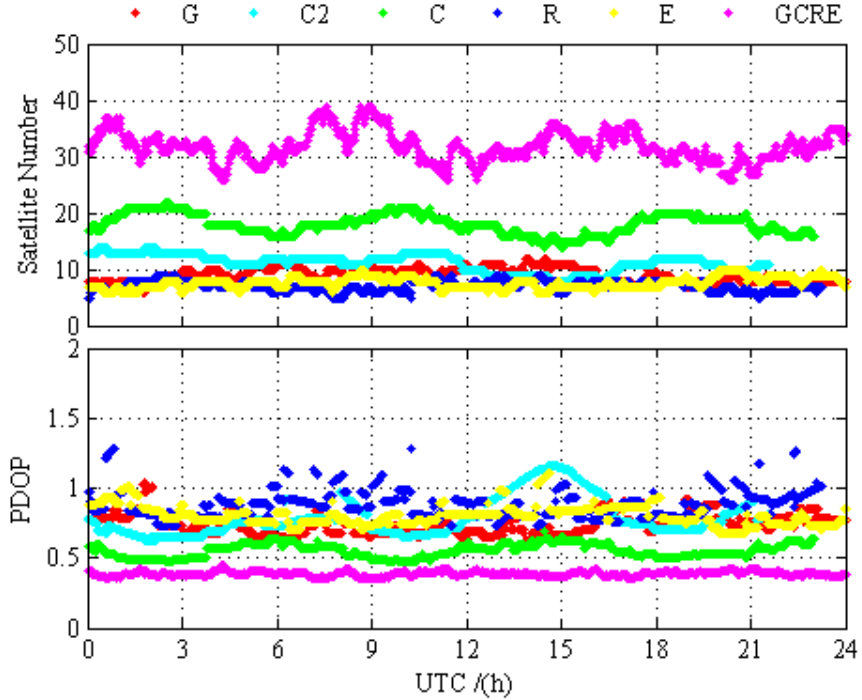
Figure 8. Number of satellite and PDOP at KUN1 for GPS-only, BDS-2-only, BDS-2/BDS-3, GLONASS-only, Galileo-only, and GPS/BDS-2/BDS-3/GLONASS/Galileo on DOY 024 in 2019.